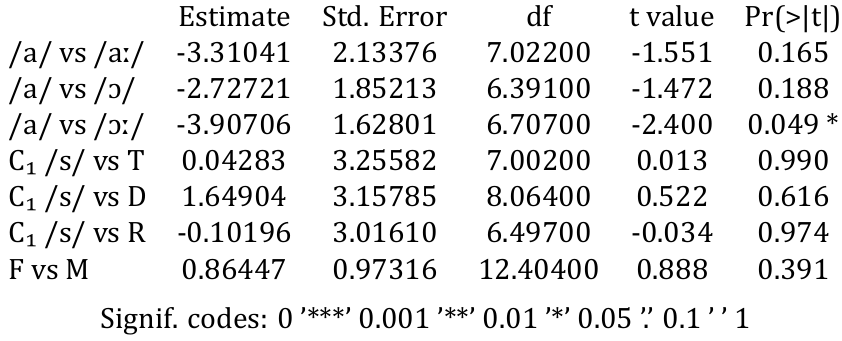
Table A.14: Pre-aspiration duration (ms) of C₂ /s/ as a dependent variable